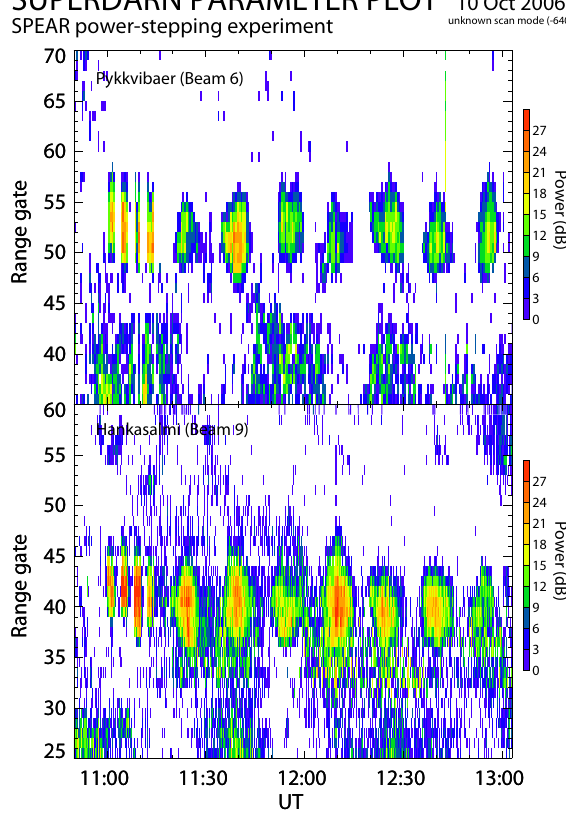
Fig. 4. Backscatter power (pwr_l) measurements from the CUT- LASS Hankasalmi (upper panel) and Þykkvibær (lower) radars dur- ing the power stepping experiment utilising SPEAR on 10 Octo- ber 2006.